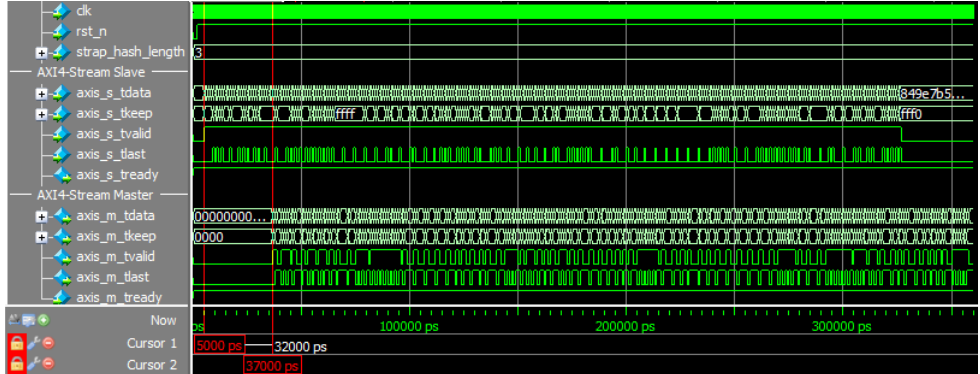
Figure 11. Simulation of netprobe_top module with the SHA-3 hash algorithm using the cocotb -based verification